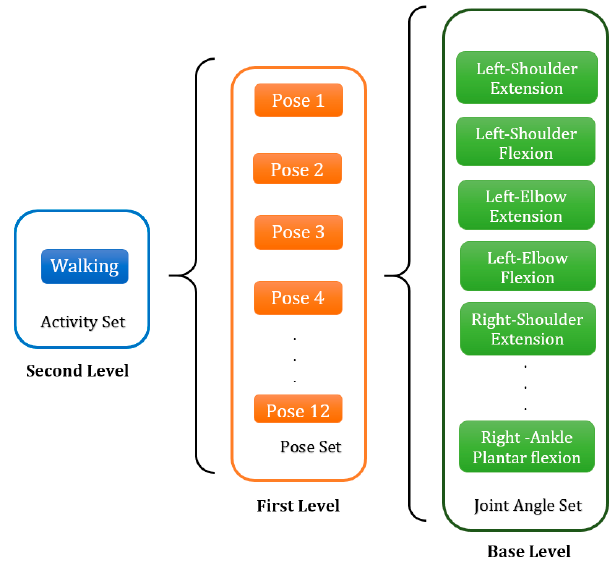
Figure 4. Walking learning framework.